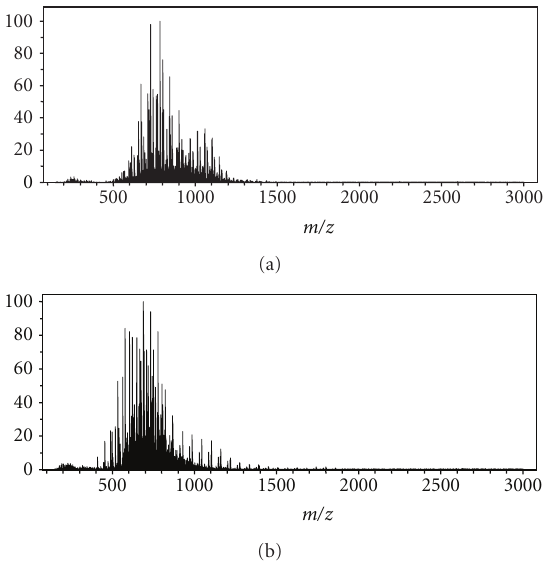
Figure 6: PS mass spectra of urine specimens from two healthy male individuals: 27 year-old (a) and 44 year-old (b).